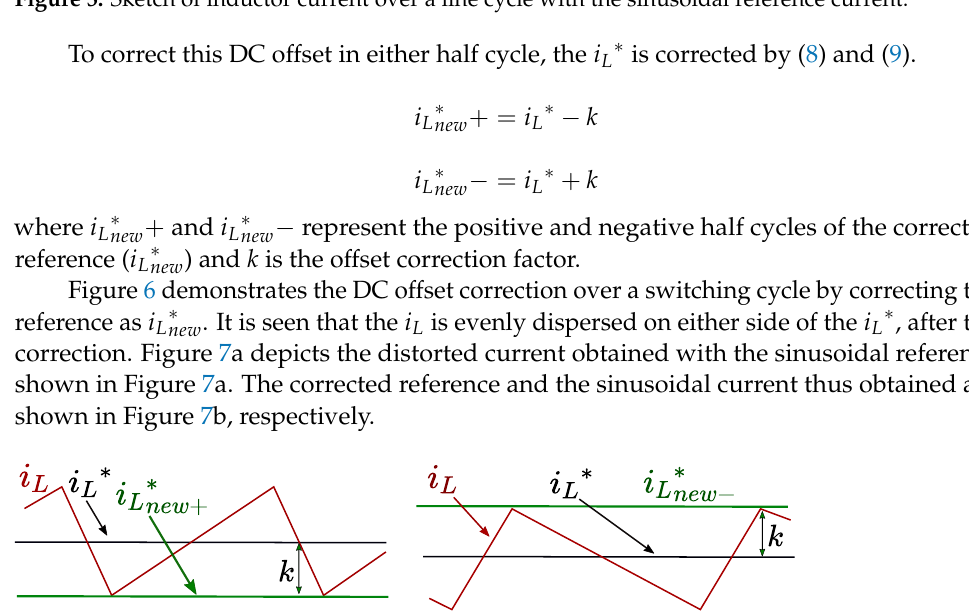
Figure 5. Sketch of inductor current over a line cycle with the sinusoidal reference current.